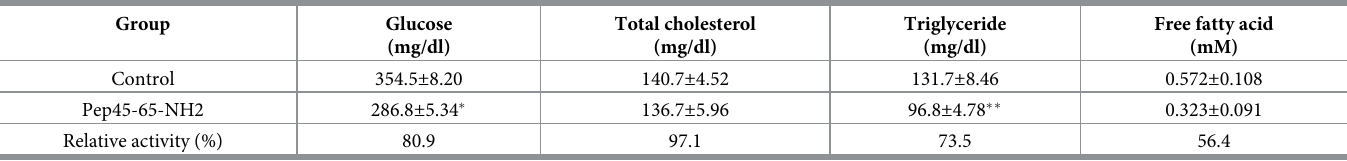
Relative activities are expressed as percentages of the values in the negative control group. Values are means ± SE (n = 6). � p < 0.001 and �� p < 0.005 compared with the negative control. Statistical analyses were performed using Student‘s t